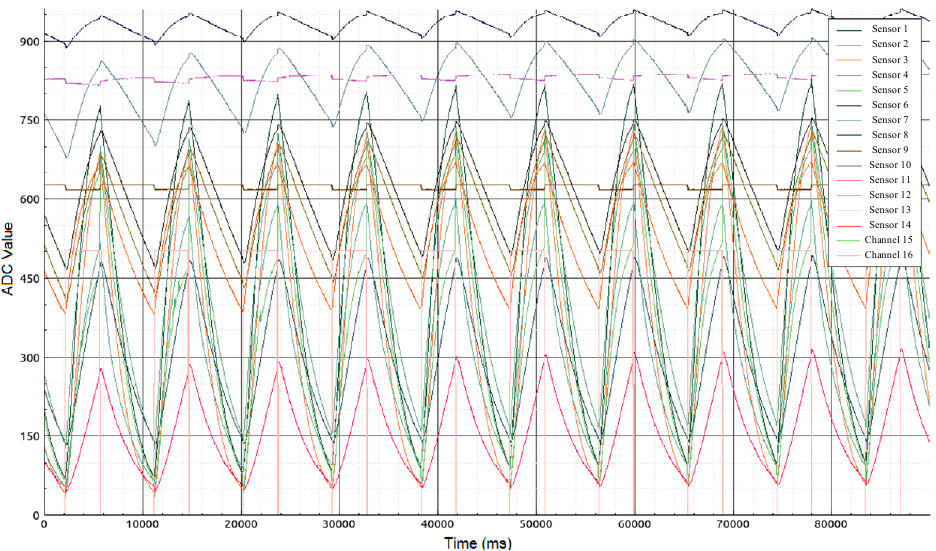
Figure 3. Form of sensor signals (ADC—analog-to-digital